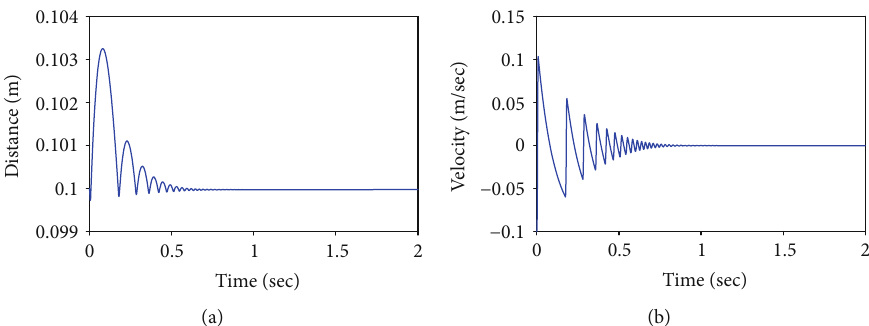
Figure 6: Dynamic response of two contact objects ( stiffness = 0 , damping = 100 ): (a) relative distance of S and S . 2